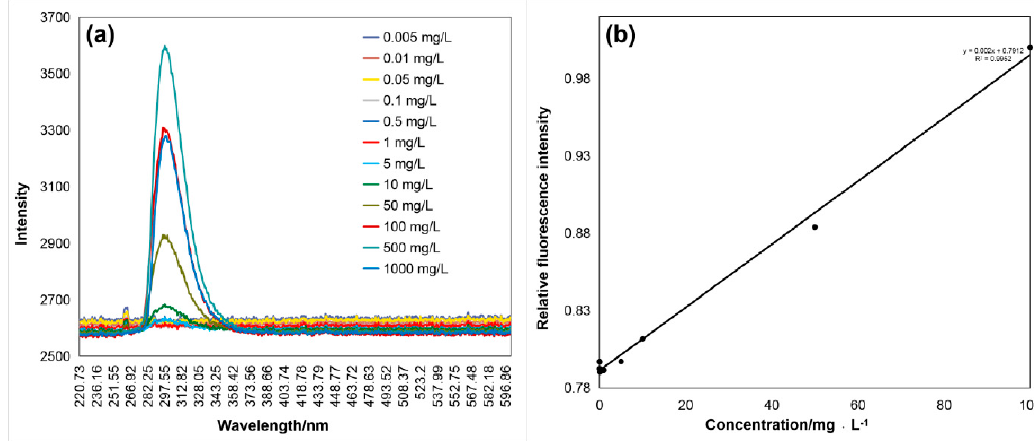
Figure 6. ( a ) Fluorescence spectrum ( λ max2 = 300 nm) of tyrosine excited by the 266 nm laser, and ( b ) relation curve between the normalized fluorescence peak intensity, I F 2 , and the tyrosine concentration, C 2 , of 5 ug/L–1 g/L with a coefficient of determination of 0.9952.